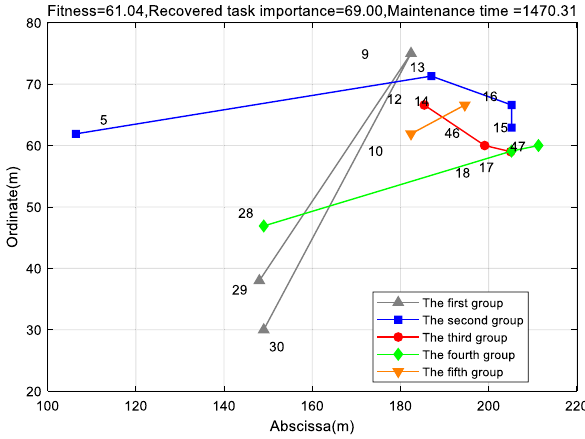
Fig. 12 Recovery strategy of genetic algorithm on improved quotient model